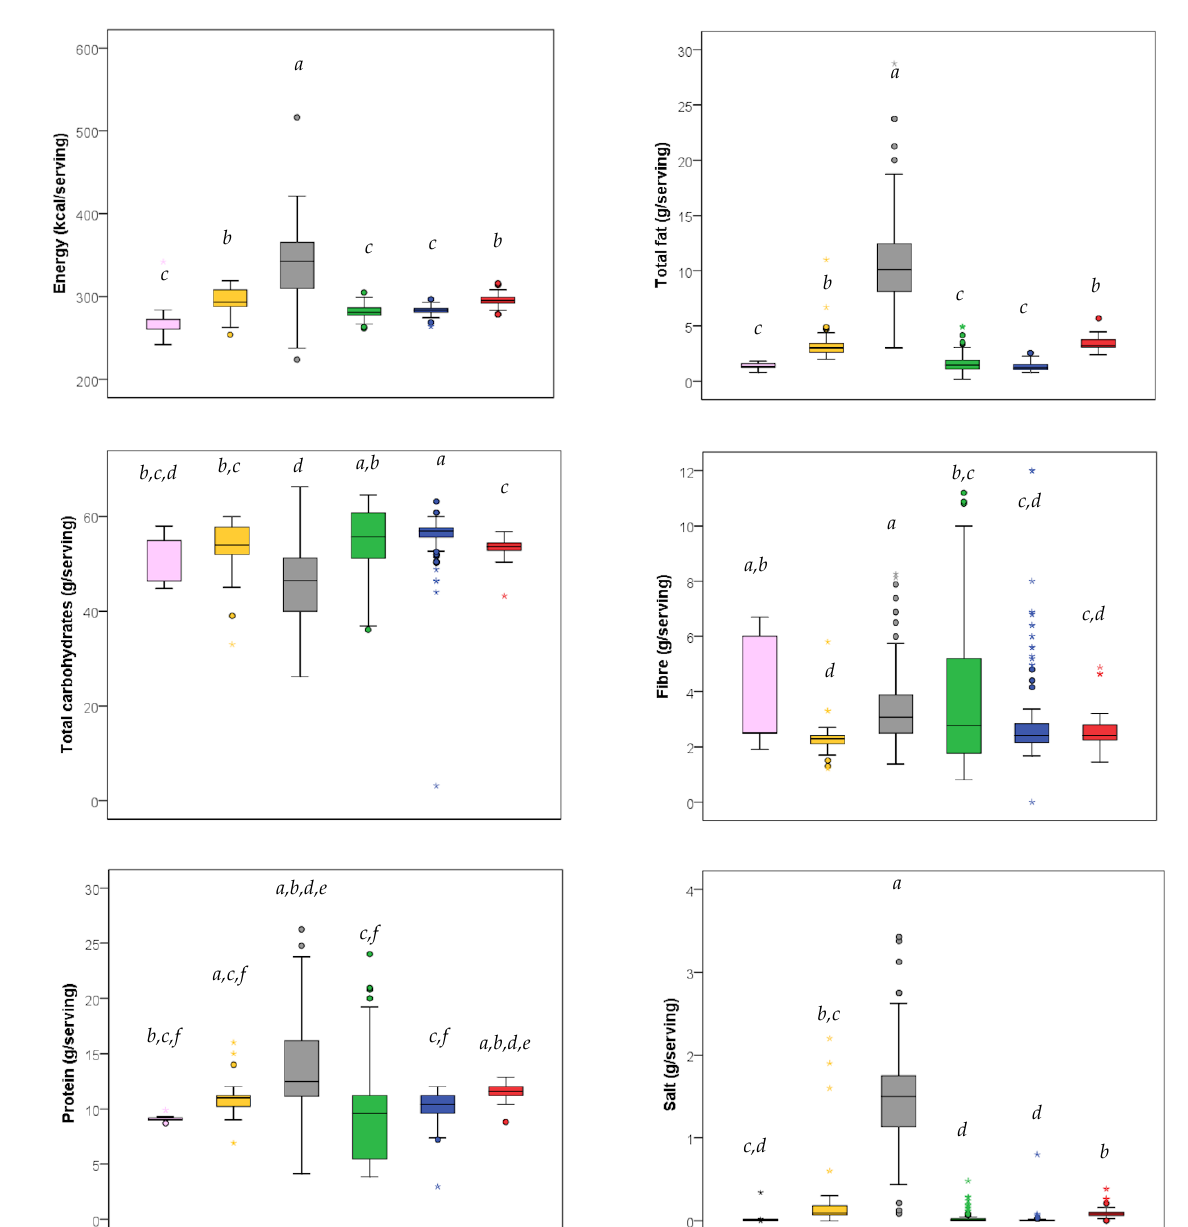
Figure 2. Box plot for energy and nutrition facts per standard serving across categories of pasta. Standard serving was 80 g for all types of dried pasta, 100 g for fresh semolina and egg pasta, and 125 g for fresh stuffed pasta. For each category, different letters indicate significant differences among pasta types (Kruskal–Wallis test for independent samples with multiple pairwise comparisons).